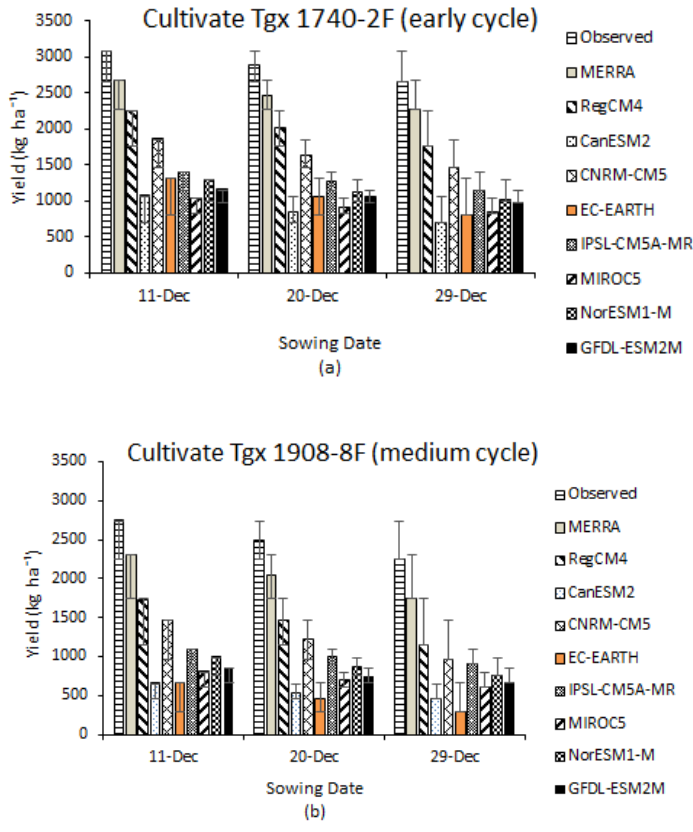
Figure 3. Simulated yield productivity values, ( a ) for Tgx 1740-2F and ( b ) Tgx 1908-8F cultivars in the period 1980–2010 for CORDEX models, MERRA reanalysis, observations and for 1990–2010 estimated